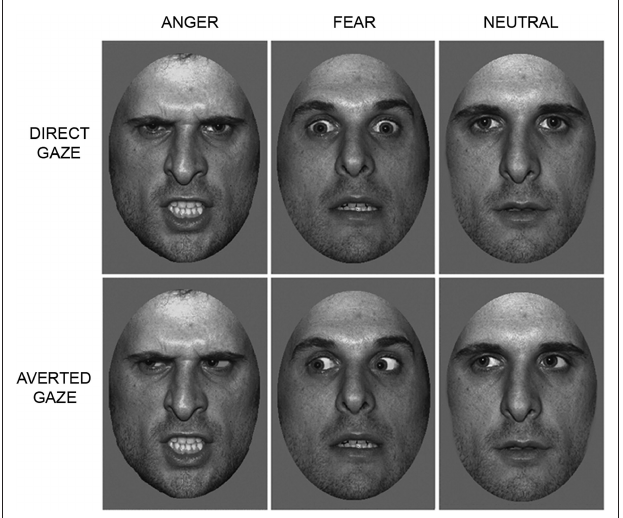
FIguRe 1 | Trials consisted of images of angry, fearful or neutral faces, displaying either a direct or averted